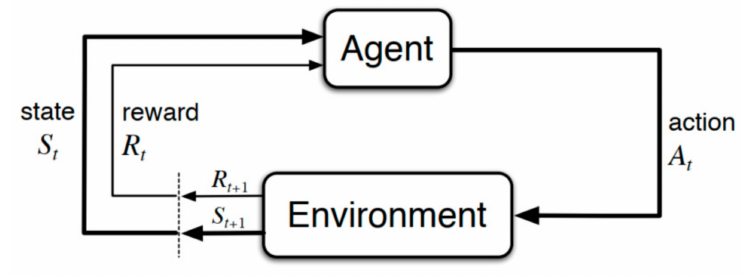
Figure 2. Agent–environment interaction in